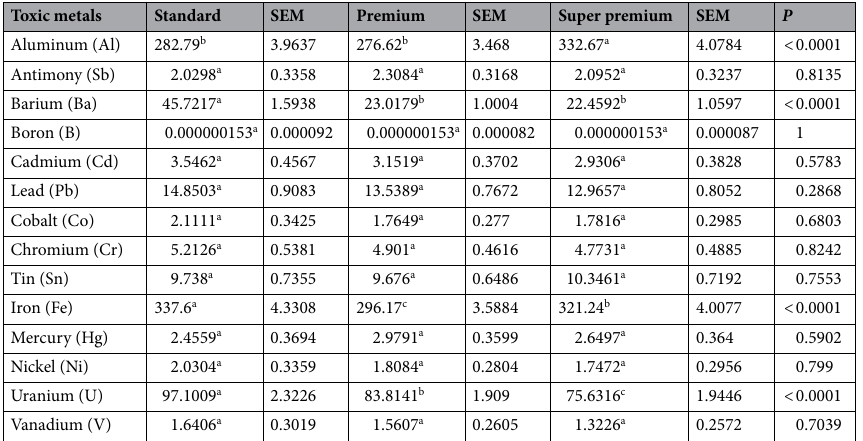
Table 9. Comparison of detected toxic metals concentrations (mg/kg) between different categories of dry dog foods. SEM standard error mean, P probability of significance. a,b Means followed by different letters in the lines differed (P < 0.05).